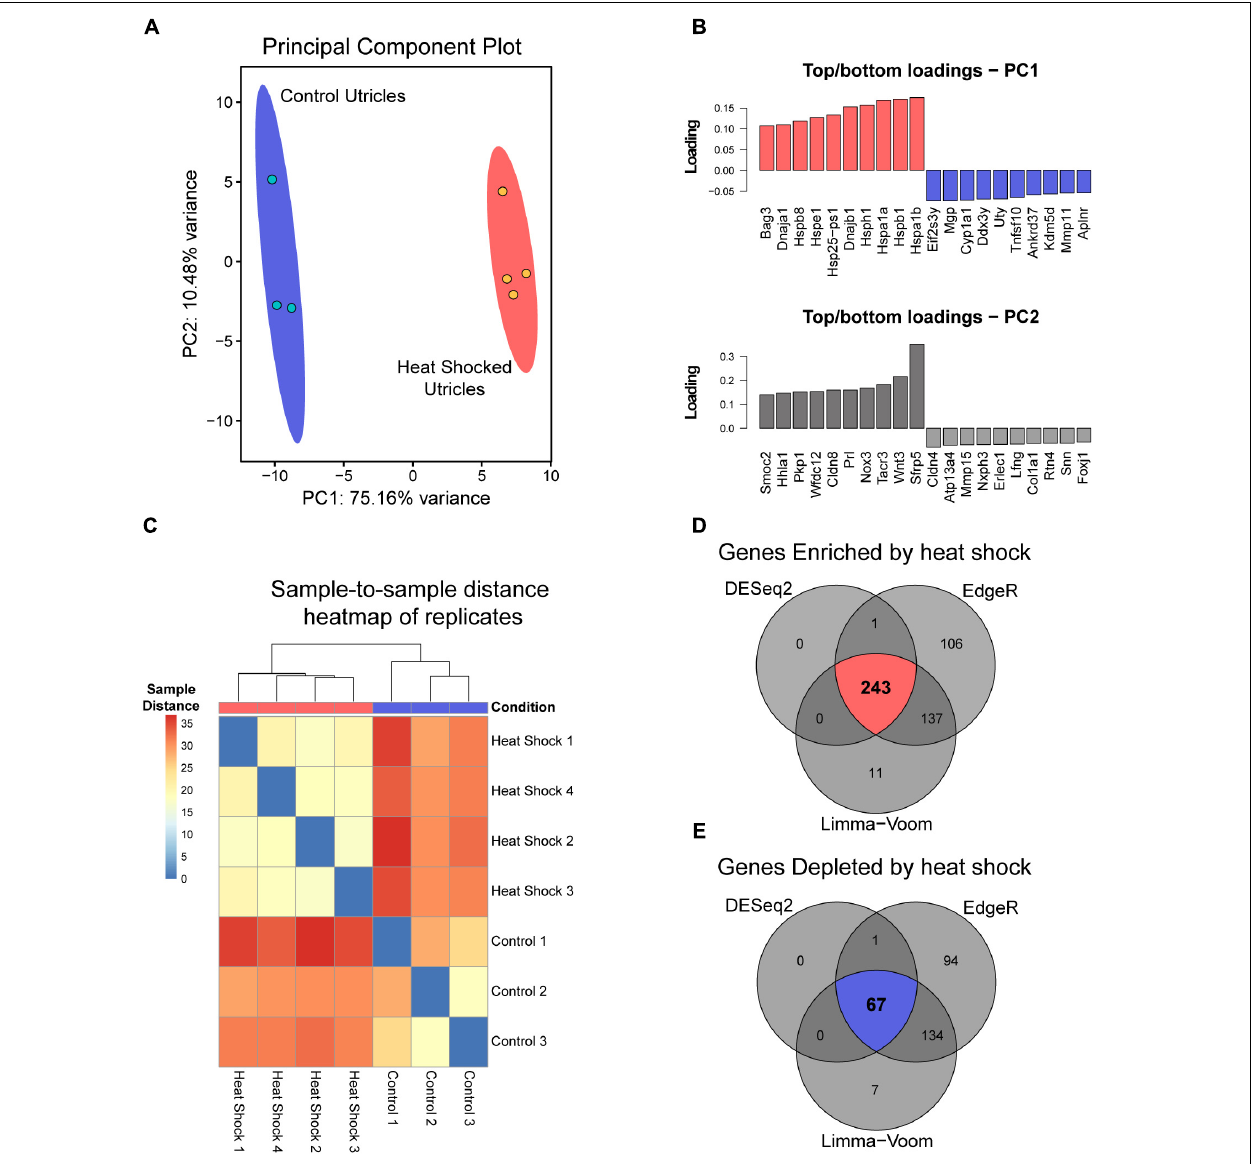
FIGURE 1 | Bioinformatic analyses of whole utricle RNA-Seq data. (A) PCA analysis of replicates from both heat shocked (red) and control (blue) utricles using the 500 most variable genes in the dataset. PC1 represents 75.16% of the total variance in the experimental data, and PC2 represents 10.48% of the total variance. The red (heat shock) and blue (control) ellipses around each set of replicates represent 95% confidence intervals. (B) Top and bottom ten transcripts that contribute to PC1 and PC2 with PCA loading values plotted for each gene. (C) Sample-to-sample distance heatmap for RNA-Seq reads with dendrograms showing hierarchical clustering of samples based on heat shock (red) and control (blue) conditions, labeled in the row above the heatmap based on sample distances. (D) Results of overlapping DEGs using DESeq2, Limma-voom, and EdgeR tools with the criteria that the log 2 fold change value must be ≥ 1 with an adjusted p-value < 0.05 for all three analysis tools. 243 DEGs were enriched in the heat shock condition relative to control (upper Venn diagram in red), and (E) 67 DEGs were depleted in the heat shock condition relative to control (lower Venn diagram in